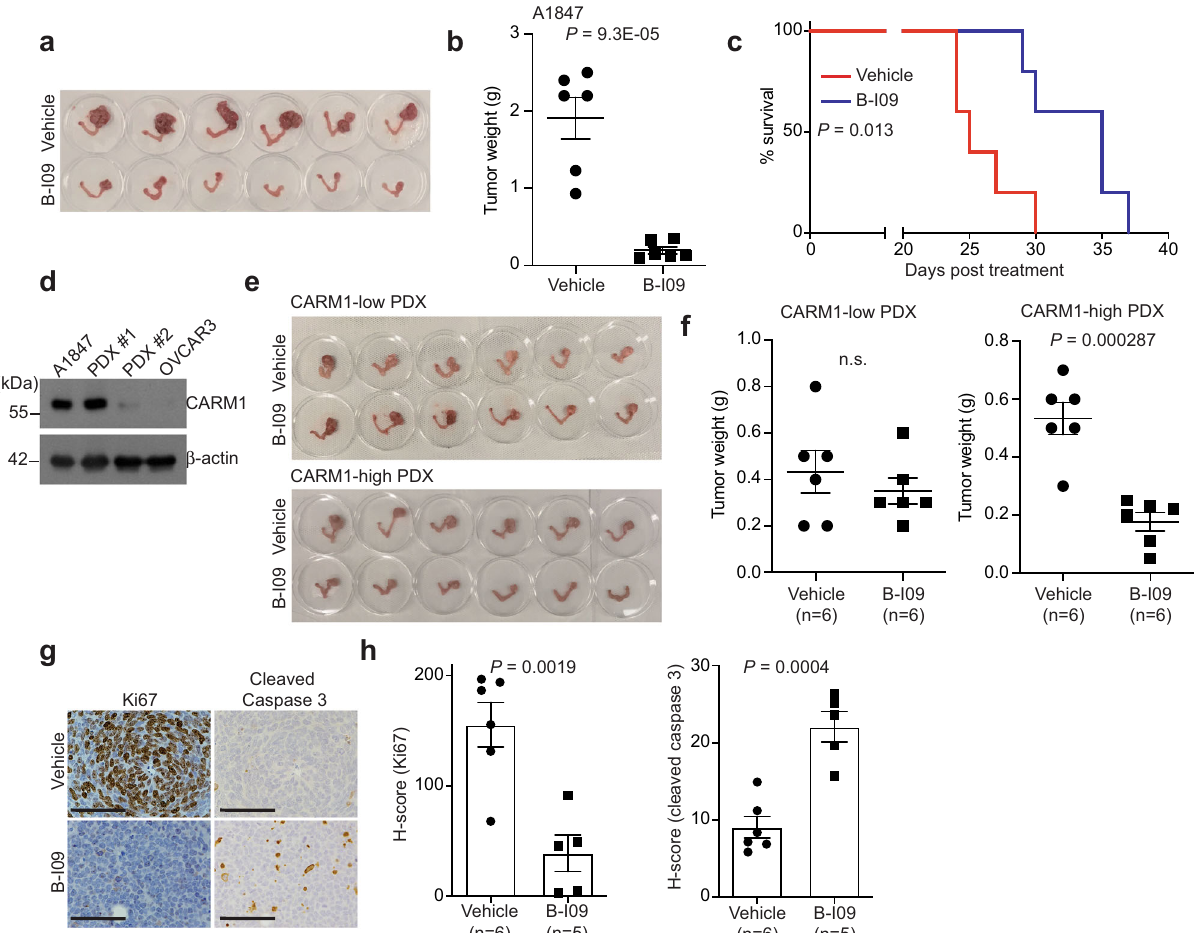
Fig. 6 CARM1 status correlates with response to IRE1 α inhibitor B-I09 in vivo. a , b A1847 cells were unilaterally injected into the ovarian bursa sac of immunocompromised mice. Tumor-bearing mice were randomized and treated with vehicle control or B-I09 (50 mg/kg, 5 weekdays/week by i.p.) for 2 weeks. After treatment, reproductive tracts with tumors from the indicated treatment groups were dissected ( a ). And tumor weights were measured as a surrogate for tumor burden ( b ). n = 6 mice per group. c After stopping the treatment, the mice were followed for survival. Kaplan – Meier survival curves for the indicated groups ( n = 5 mice per group). P value was calculated by log-rank test. d Expression of CARM1 and a loading control β -actin in the indicated CARM1-high and CARM1-low PDXs determined by immunoblot. Immunoblots are representative of two biologically independent experiments with similar results. A1847 and OVCAR3 cells were used as controls for CARM1-high and CARM1-low expression, respectively. e , f Mice bearing the indicated orthotopic CARM1-high and CARM1-low HGSOC PDXs were randomized and treated with vehicle control or B-I09 (50 mg/kg, 5 weekdays/week by i.p.) for 2 weeks. Reproductive tracts with tumors from the indicated treatment groups were dissected ( e ). And tumor weights were measured ( f ). g Tumors from CARM1-high group were subjected to immunological staining for an apoptotic marker cleaved caspase 3 and a cell proliferation marker Ki67. Scale bar = 100 μ m. h Histological score ( H score) of the indicated markers was quanti fi ed from three separate fi elds of each tumor, six tumors from vehicle group, and fi ve tumors from B-I09 group were analyzed. Data represent mean ± SEM. P values were calculated using two-tailed t test except for c by log-rank (Fig. 7f and Supplementary Fig. 6g). Although CD8 T cell in fi ltration was not affected by B-I09 treatment, activation of both CD4 and CD8 T cells was increased by B-I09 treatment (Fig. 7f). Consistent with previous reports 19,24 , B-I09 treatment decreased both intra-tumoral and spleen monocytic myeloid-derived suppressor cell (MDSC) and polymorphonuclear MDSC (Fig. 7f and Supplementary Fig. 6h). The combination treatment did not signi fi cantly decrease the body weight of the treated mice, and histological analyses of the liver, kidney, and spleen harvested at the end of the experiment from combination- treated mice revealed no overt abnormalities (Supplementary Fig. 6i, j), suggesting that the combination treatment was well tolerated. Together, we conclude that inhibition of the IRE1 α /XBP1s pathway is synergistic with immune checkpoint blockade in CARM1-expressing EOCs in vivo.